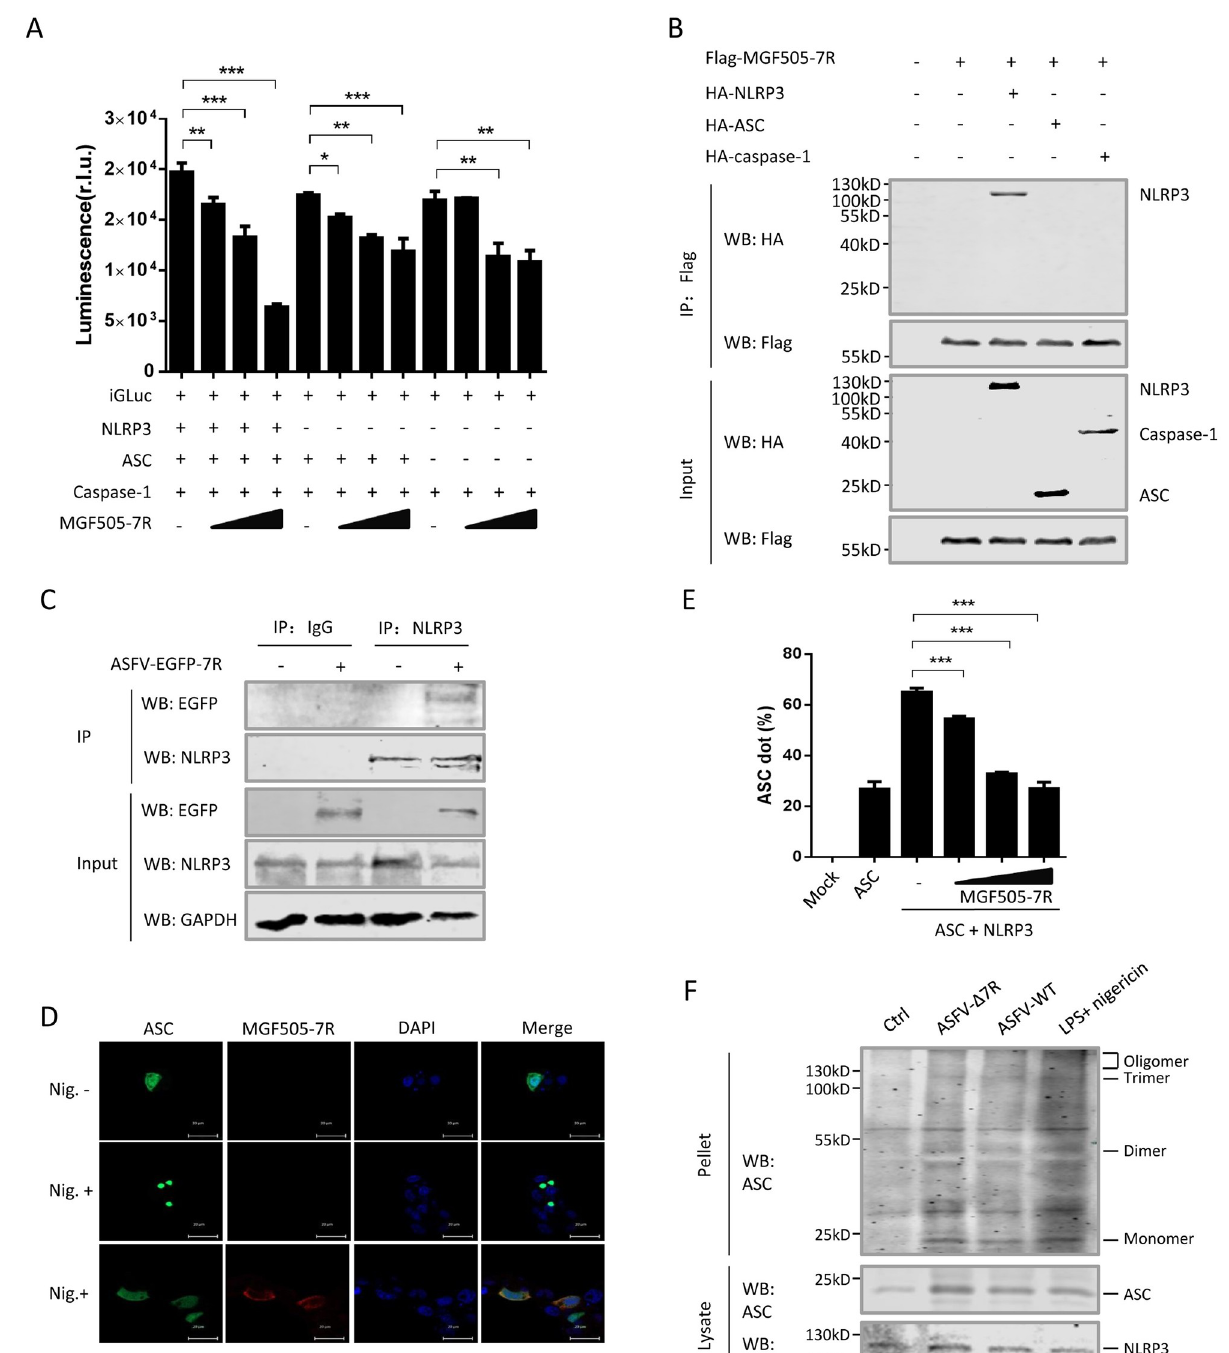
Fig 7. pMGF505-7R targets NLRP3 to inhibit inflammasome complex formation. (A) HEK293T cells were transfected with different doses of MGF505-7R in the presence of the iGLuc-based NLRP3 inflammasome system or the system lacking NLRP3 or both NLRP3 and ASC, and the supernatants were assessed for luciferase activity at 24 h after transfection. (B) HEK293T cells were transfected with a plasmid encoding pMGF505-7R along with a plasmid encoding HA-tagged NLRP3, ASC or caspase-1. 36 hpt, the cells were lysed and whole cell lysates (WCL) were immunoprecipitated with anti-Flag mAb. The immunoprecipitants were detected by immunoblotting with antibodies indicated. (C) PAMs were either mock-infected or infected with ASFV-EGFP-7R (1 MOI) for 36 h, and then a Co-IP was performed with anti-NLRP3 antibody. IgG was used as a negative control. (D) The PAM cell line 3D4/21 (CRL-2843) were transfected with a plasmid encoding GFP-ASC alone or together with Flag-MGF505- 7R. At 24 hpt, cells were stimulated with Nigericin (5 μ M) for another 4 h. The cells were then fixed and probed with rabbit anti-Flag mAb and GFP,